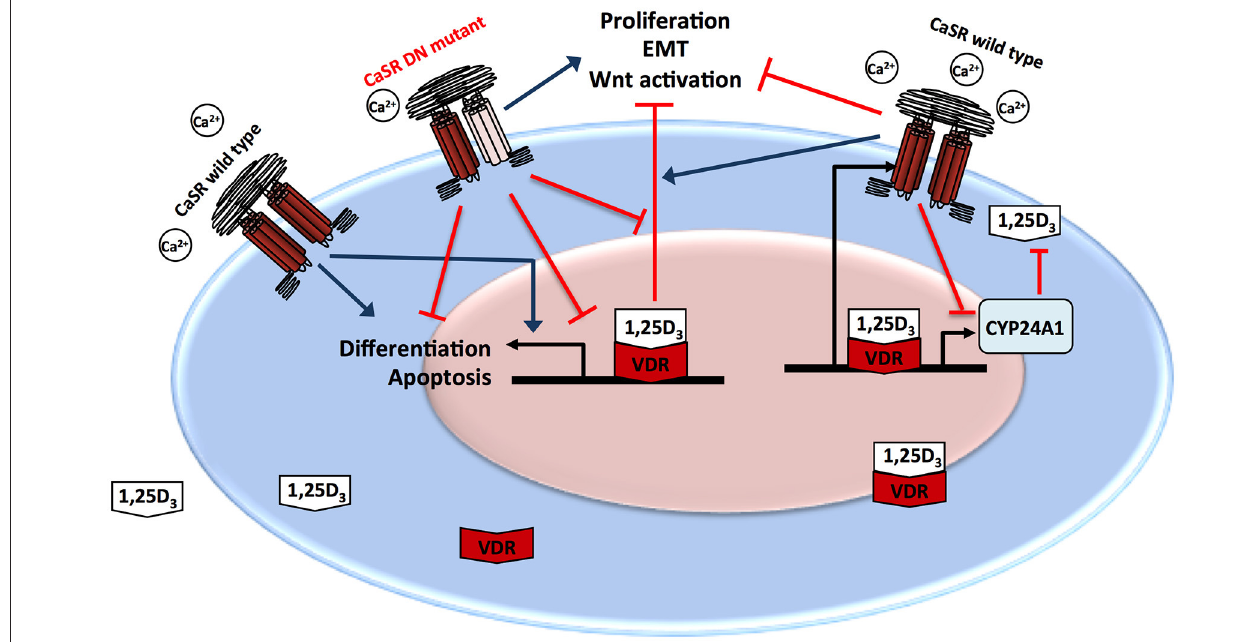
FIGURE 2 | Interactions between the vitamin D system and the CaSR. Ca/CaSR and the 1,25D 3 /VDR cross talk to protect colonic epithelial cells from malignant transformation. 1,25D 3 is able to up regulate expression of both, CaSR and Cyp24a1. The wild type CaSR has a tumor suppressive role in the colon promoting (blue arrows) differentiation and apoptosis and suppressing (red arrows) proliferation and EMT and potentiates the tumor preventive effects of 1,25D 3 . The presence of a DN mutant CaSR abrogates the tumor preventive effects of both Ca and 1,25D 3 .